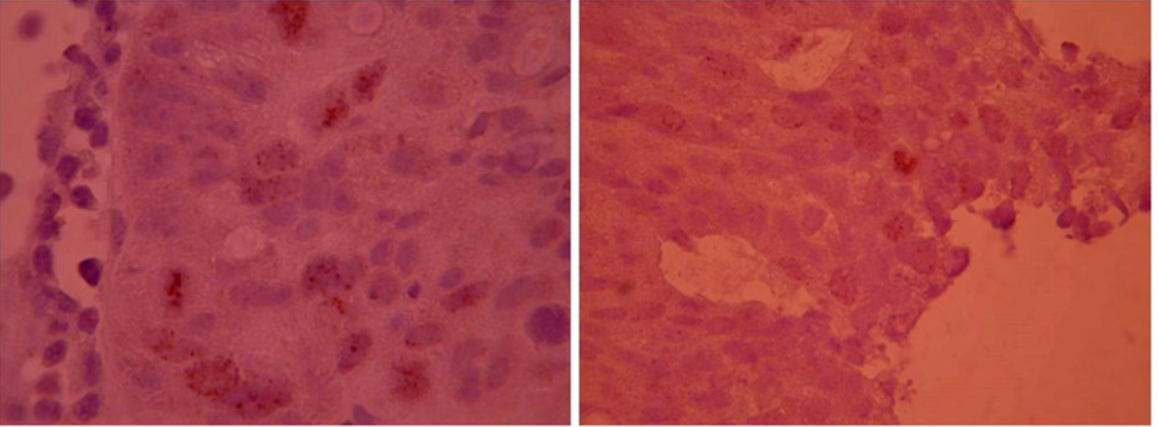
Fig. 2. Positive Survivin IHC staining in 10% of nuclear tumoral cells. Table 1. HER2 expression staining grade according to the positive control of breast carcinoma samples (21). Staining pattern score HER2 overexpression assessment 0